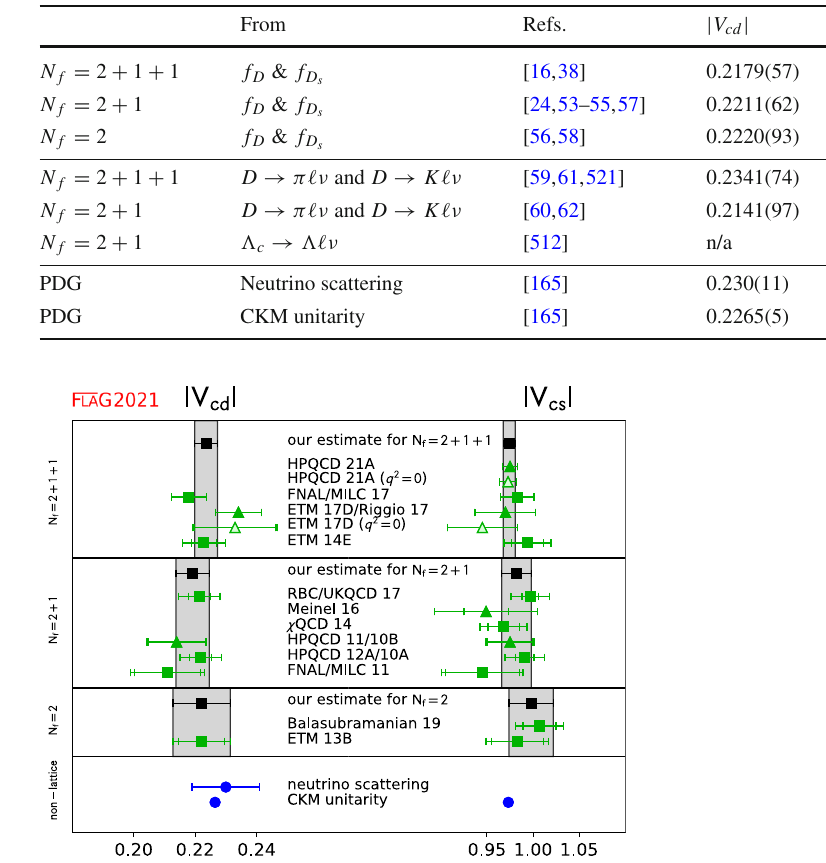
Fig. 26 Comparison of determinations of | V cd | and | V cs | obtained from lattice methods with nonlattice determinations and the Standard Model prediction based on CKM unitarity. When two references are listed on a single row, the first corresponds to the lattice input for | V cd | and the second to that for | V cs | . The results denoted by squares are from leptonic decays, while those denoted by triangles are from semileptonic decays. The points indicated as ( q 2 = 0) do not contribute to the average, and are shown to stress the decrease in the final uncertainty obtained by considering the full q 2 dependence. Notice that the HPQCD 21A point includes estimates of the electroweak and soft electromagnetic uncertainties that we have